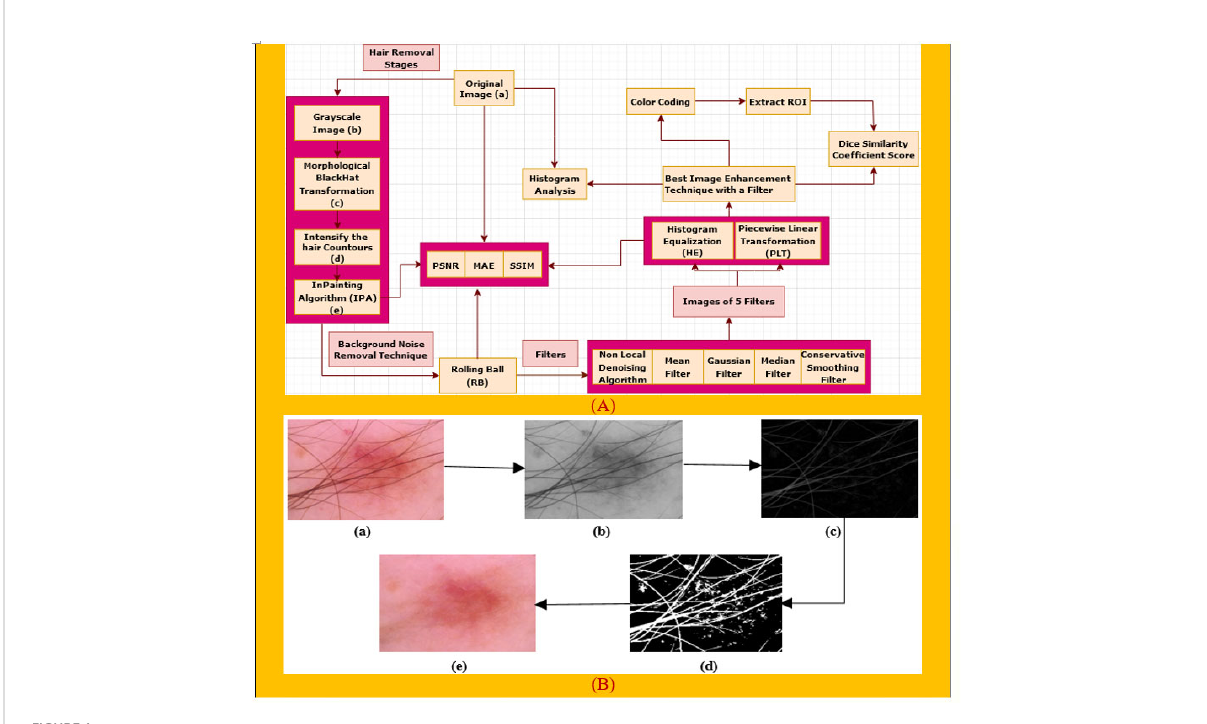
FIGURE 1 (A) Preprocessing technique of our proposed system. (B) The DHR process diagram, consisting of the (a) original image, (b) grayscale image, (c) morphological BlackHat operation, (d) intensi fi cation of the hair contours, and (e) Inpainting